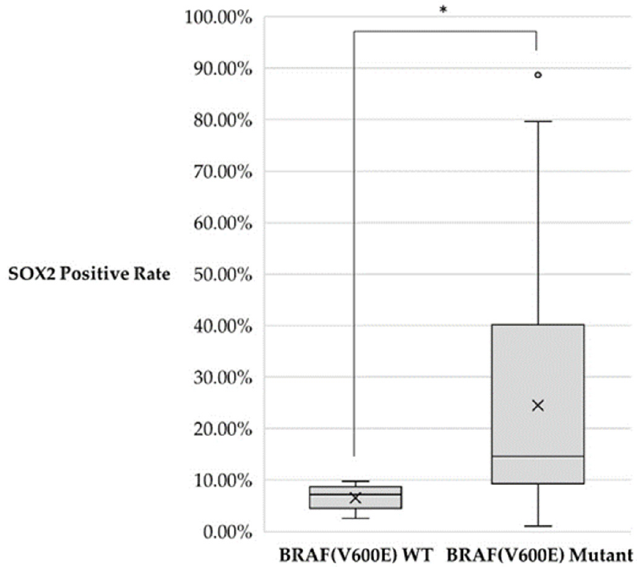
Figure 7. Representative wild type BRAF and BRAF(V600E) mutant sequence chromatograms of BRAF exon 15 (portion) were shown. * The BRAF c.1799 T > A mutation resulting in a heterogeneous thymine-to-adenine transversion at nucleotide position 1799, which results in a valine-to-glu- tamate substitution at residue 600 (BRAF V600E mutation rs113488022) was confirmed to be pre- sent in ameloblastomas.